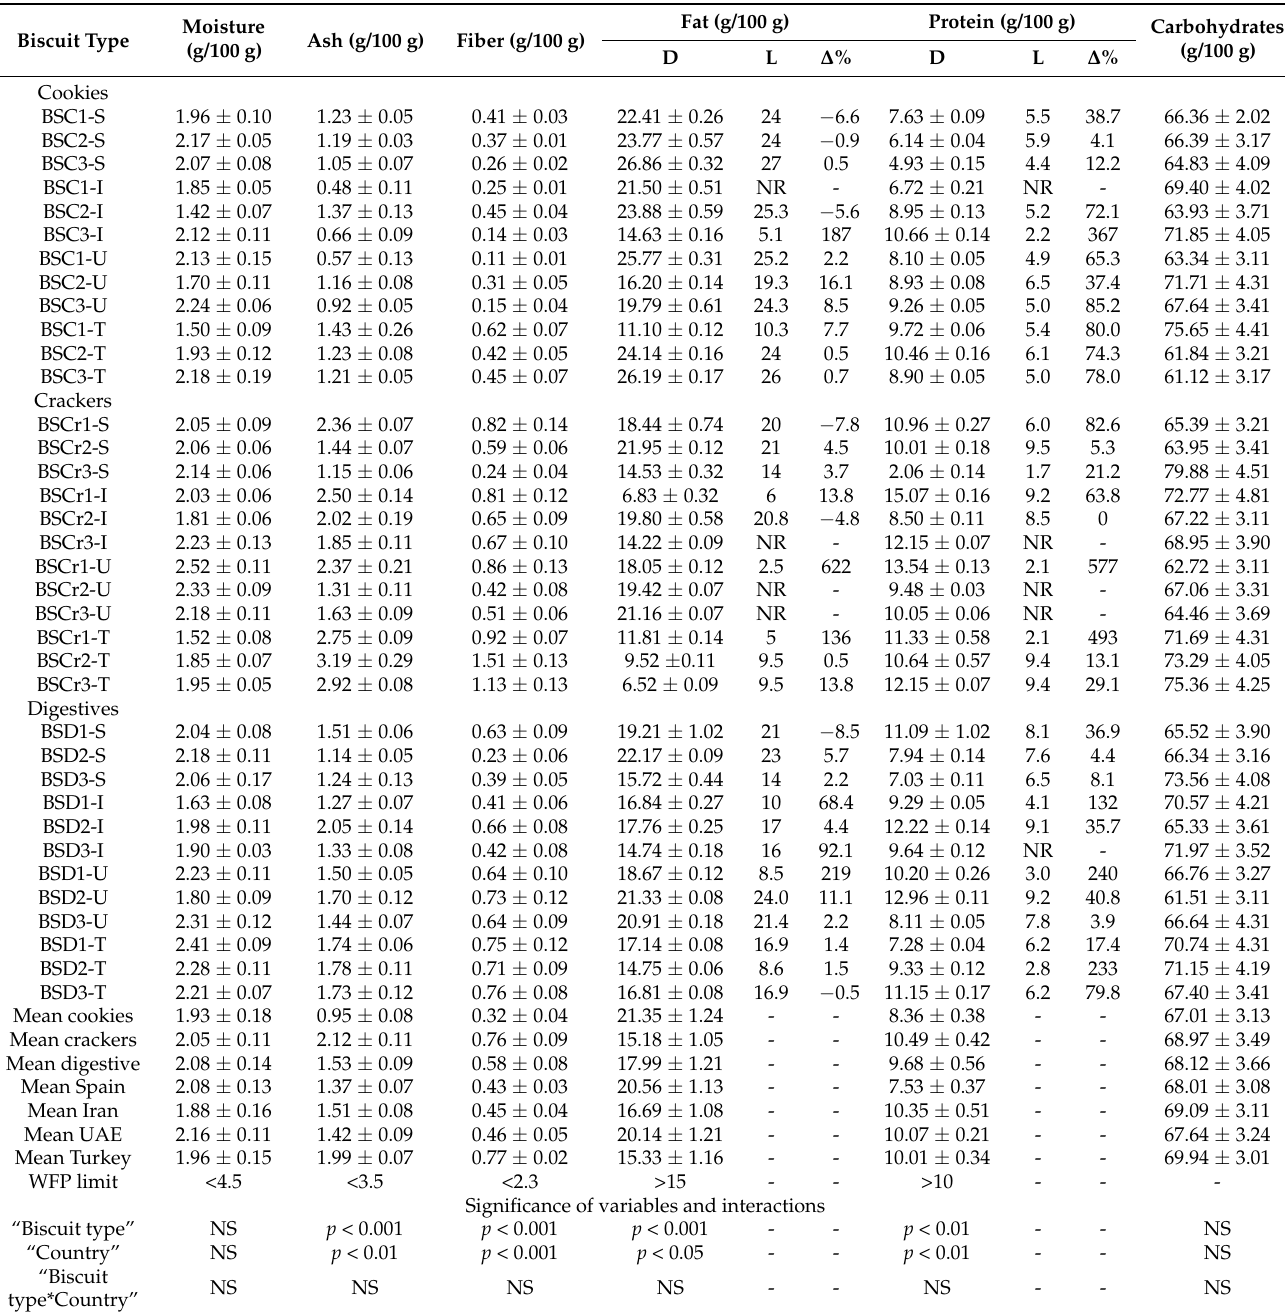
Table 1. Nutritional composition of biscuits marketed in Basrah,